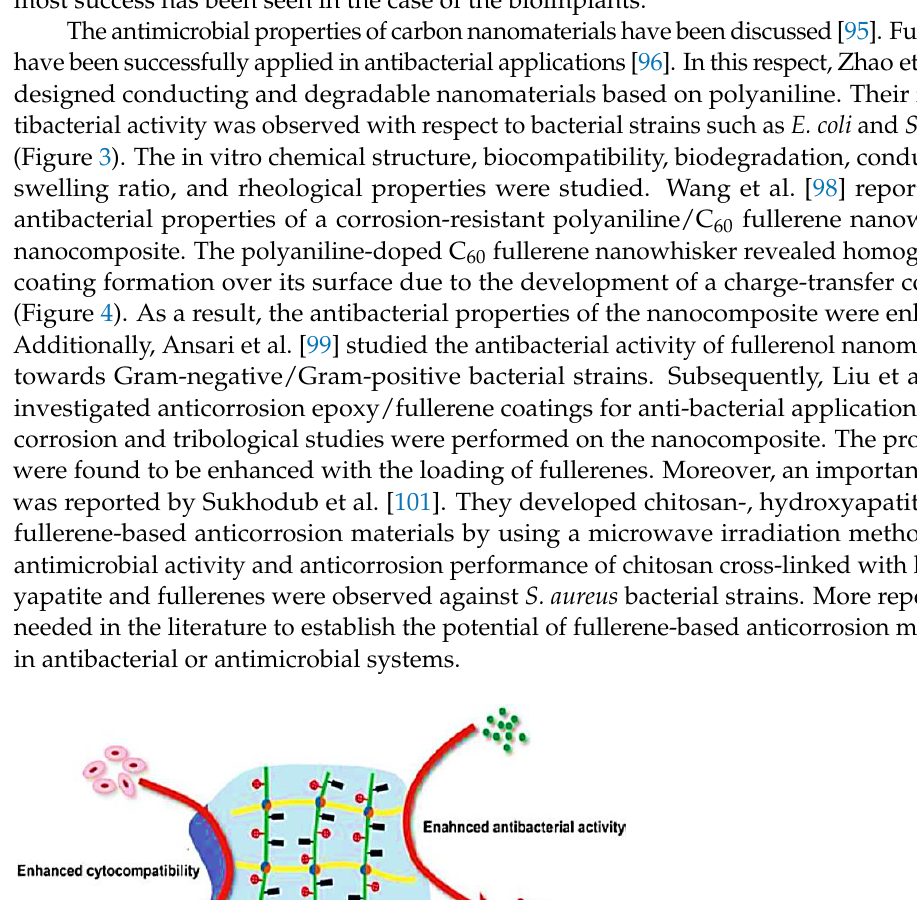
Figure 4. SEM images of ( a ) a fullerene nanowhisker and ( b ) a polyaniline-doped nanowhisker [98]. Reproduced from Hindawi (published with open access). Fullerene nanoparticles have been used in the drug delivery field [102,103]. Fuller- ene-derived nanomaterials were found to be capable of delivering chemotherapeutics, nu- cleic acid, and cardiovascular drugs directly to cancerous cells. An important study by Hasiao et al. [104] explored the use of polyaniline/poly(lactic-co-glycolic acid) nano- materials for drug delivery (Figure 5). Simulation studies on the electrical conductivity and cytotoxicity were performed for the nanomaterials. Subsequently, Thong et al. [105] synthesized polyaniline- and fullerene-based nanocomposites for drug delivery. The nanocomposites also had anticorrosion properties. Polyaniline was used in the emerald- ine and leucoemeraldine forms. More polymer/fullerene nanocomposite designs have been observed for drug delivery applications [106]. C 60 -based molecules were found to be useful in drugs for resisting bacteria, fungi, and pathogens [107]. Later, Biswas et al. [108] designed a silver-nanoparticle- and fullerene-based nanomaterial for effective anti-can- cerous drug delivery. Anticorrosion properties are desirable for preventing dose-depend- ent toxic effects in vitro. The use of silver-nanoparticle-decorated C 60 endo-fullerenes with antimicrobial and anticorrosion properties could bring revolutionary changes in the field of drug treatment regimes. Again, more efforts are required in the literature to see the in vivo and in vitro toxic effects and anticorrosion performance of fullerene-based materials in drug delivery systems.